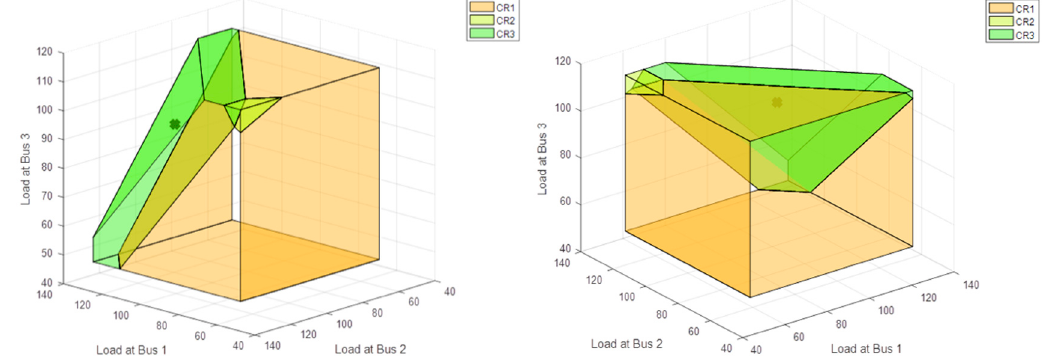
Figure 6. State space diagrams shown at different angles for IEEE 3-Bus case where the x -mark stands for the current dispatch.